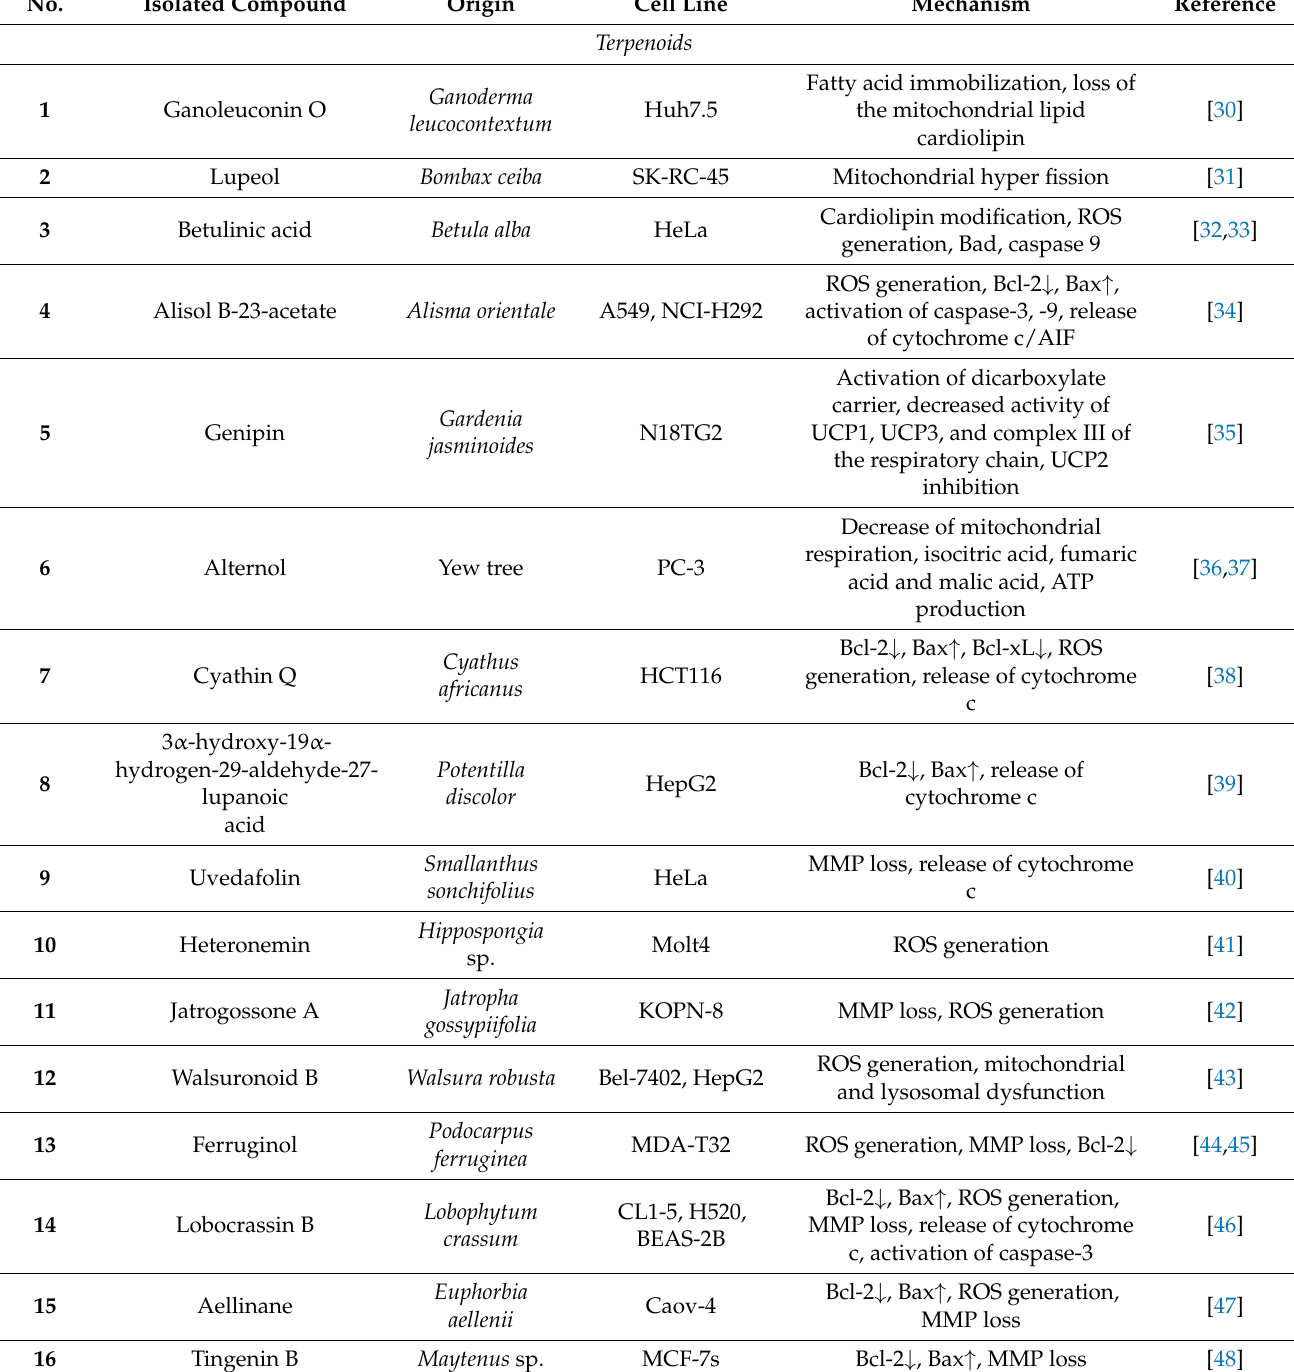
Table 1. Natural products ( 1–81 ) regulated mitochondria by different mechanisms in cancer